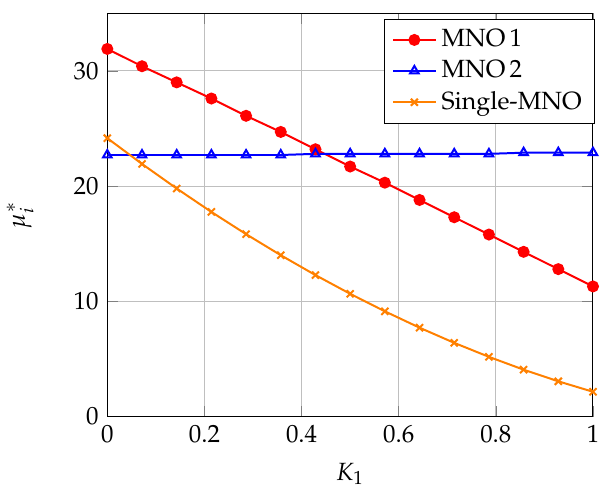
Figure 9. MNO i ’s network capacity as a function of K 1 with K 2 = 0.45.